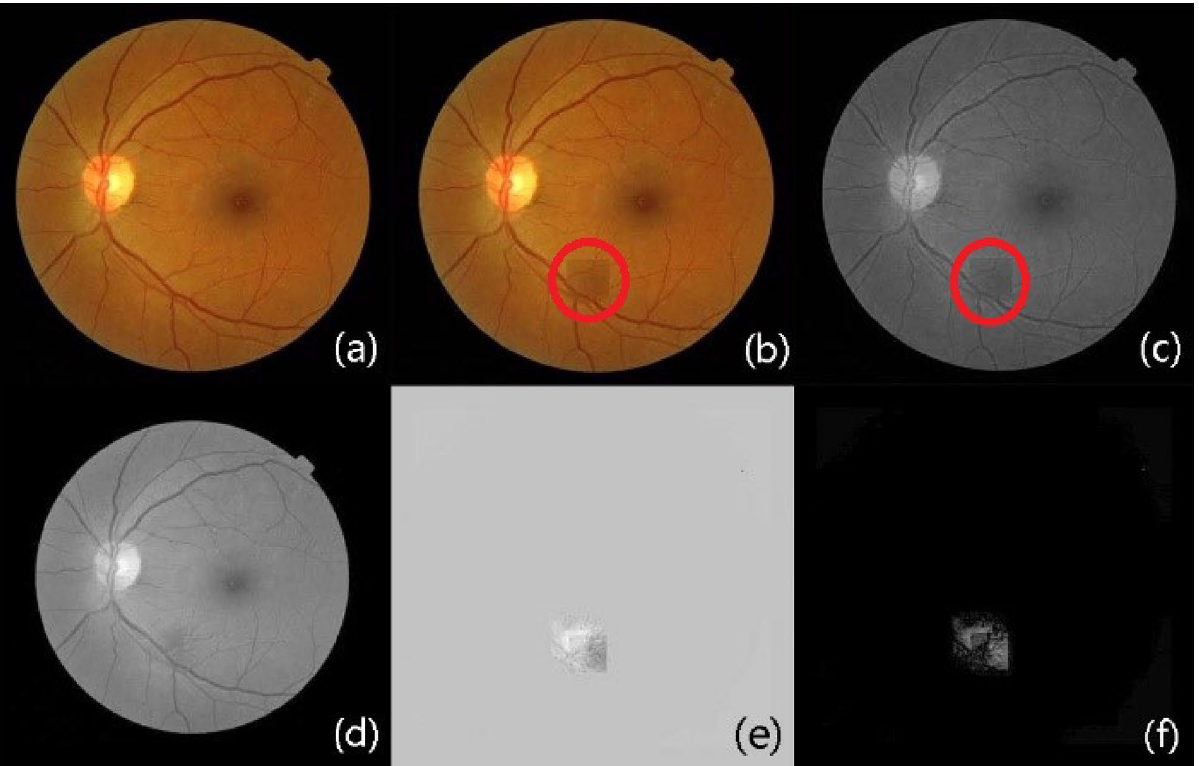
Figure 13. The result of simulated image pair. ( a ) The normal retinal fundus image from DRIVE; ( b ) the image attached with marked by the red circle; ( c ) grayscale image of ( b ); ( d ) the reconstructed background of ( c ) based on the proposed method; ( e ) the difference image of ( c ) and ( d ); ( f ) the absolute difference image of ( c ) and ( d